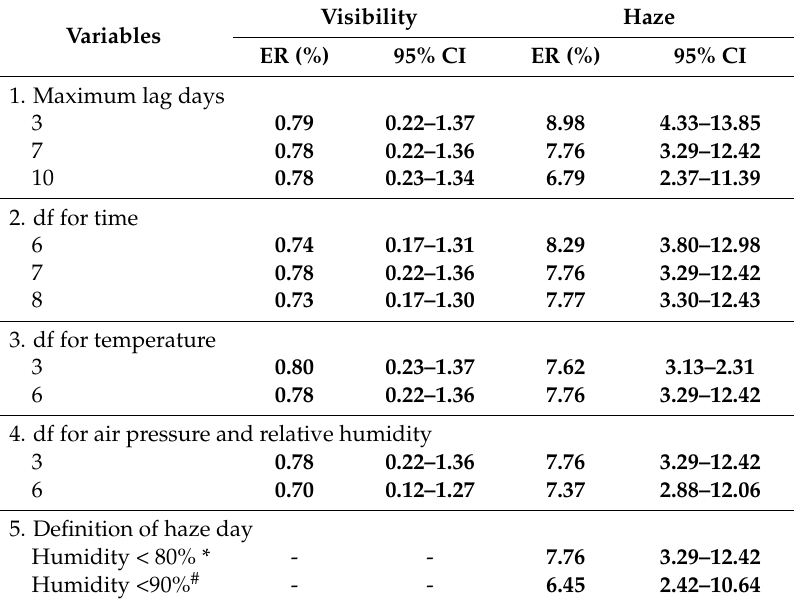
Table 4. Sensitivity analyses of the excess risk (ER%) for total mortality with per 1 km decrease of visibility at lag day 0 and in haze days at 0–2 lag days, by changing maximum lag days, degree of freedom (df) and definition of